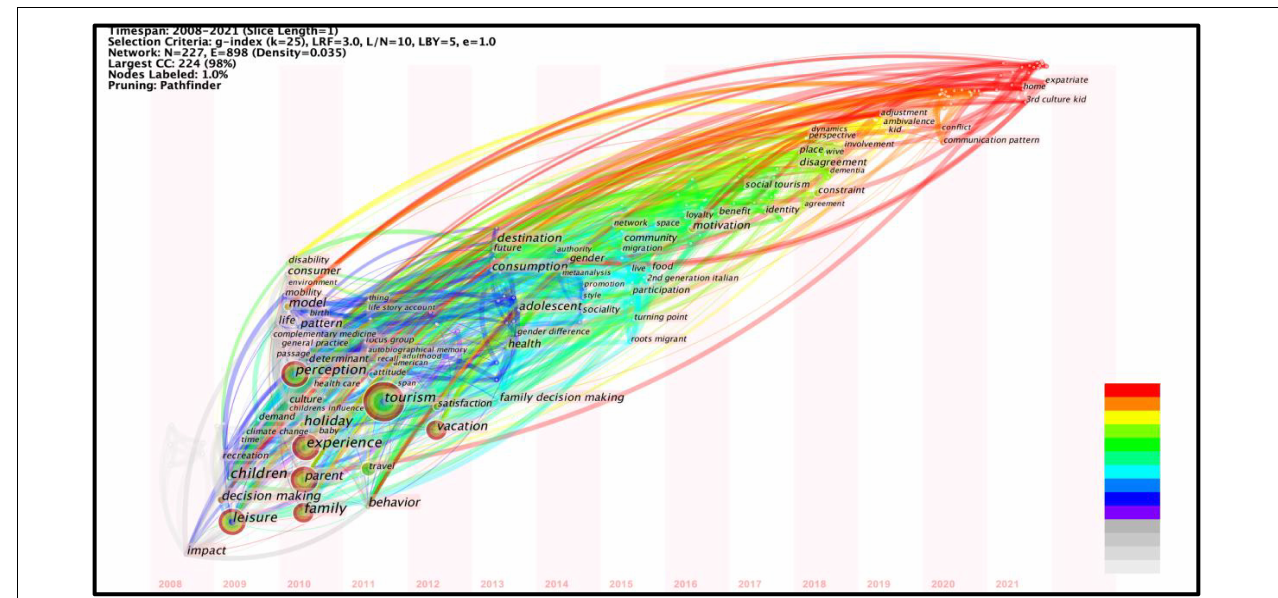
FIGURE 4 | A time-zone view of keywords with high frequencies from